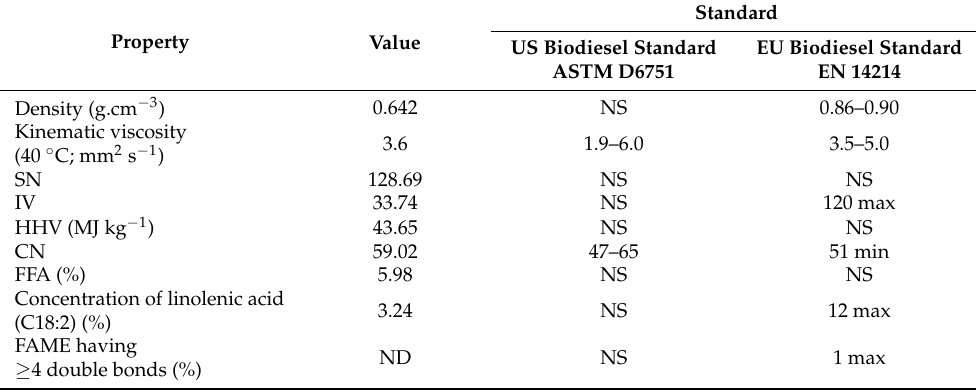
Table 3. Properties of fatty acid methyl esters produced by immobilized lipases transesterification